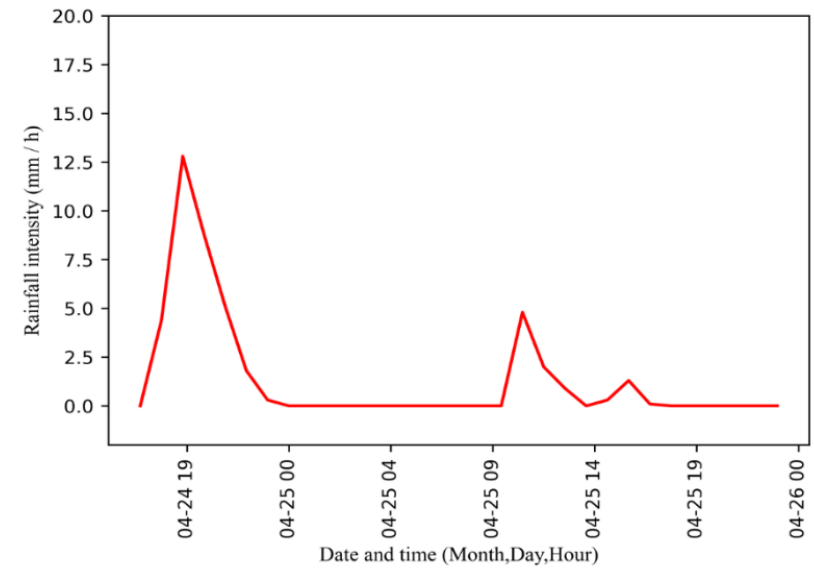
Figure 2. Rainfall intensity during a flash flood on 24 April 2018.